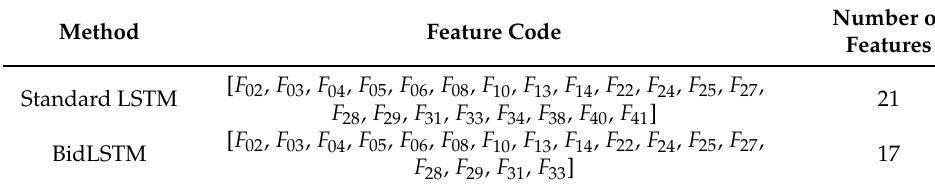
Table 12. The selected optimal set of features.